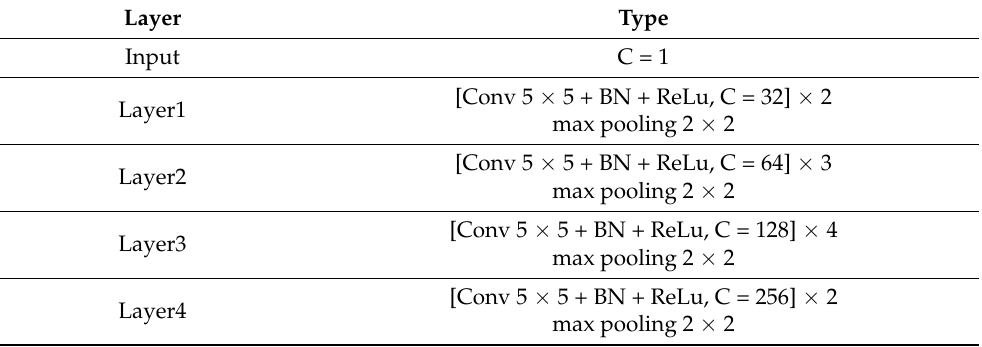
Table 1. Details of multi-scale feature extraction module.